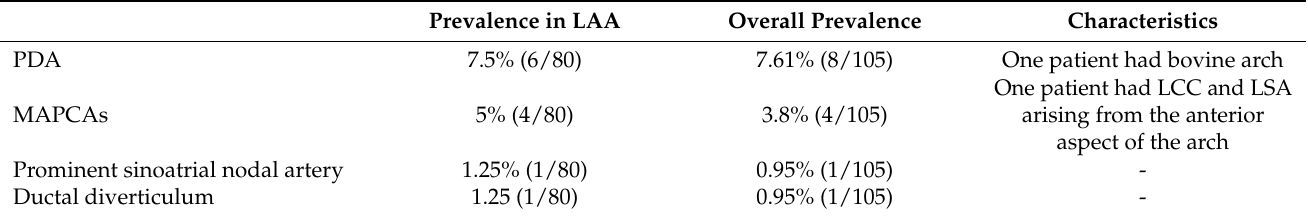
Table 5. Other vascular